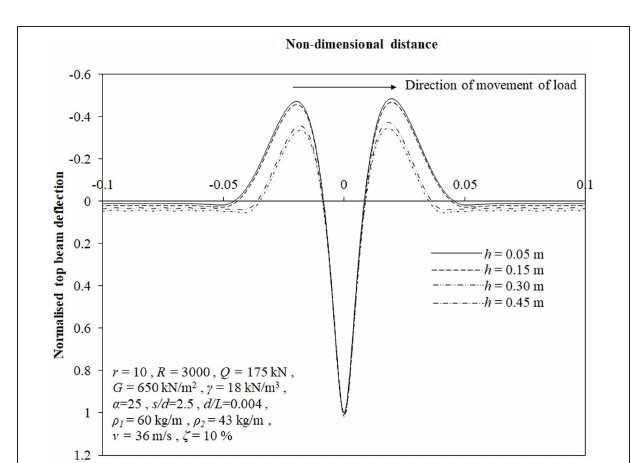
FIGURE 10 | (A) Deflection of top beam at different s/d values. (B) Deflection of top beam for various d/L values.